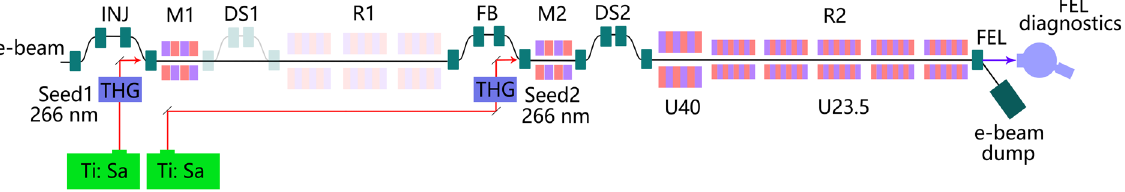
FIG. 1. Layout of the EEHG experiment at the SXFEL. INJ, injection chicane; M, modulator; FB, fresh-bunch chicane; DS, dispersion section; R,